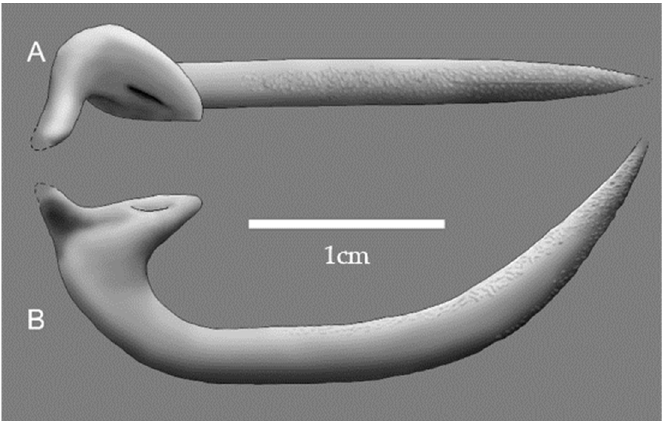
Figure 4. Reconstruction of the probable original appearance of the examined onychite. Basal ( A ) and lateral adprocessal ( B ) views. Scale bar, 1 cm.